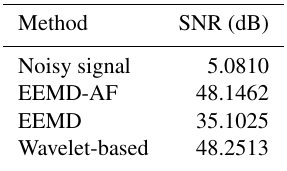
Table 2. Correctional result comparison of SNR of different meth-